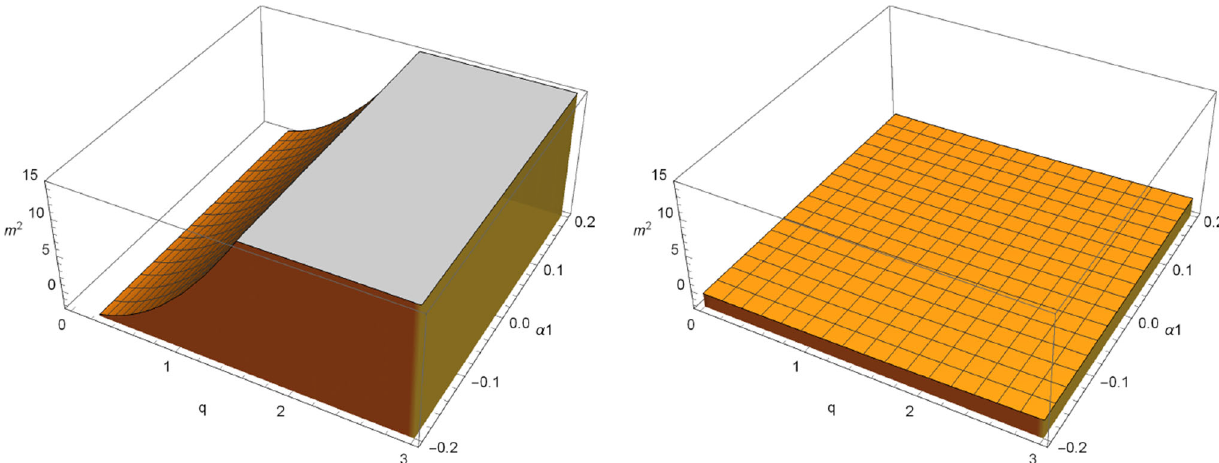
Fig. 6 3D plot of the allowed region for the superconducting phase transition at the zero temperature for a fixed γ (left plot is for γ = − 1 / 12 and right plot is for γ = 1 / 12)